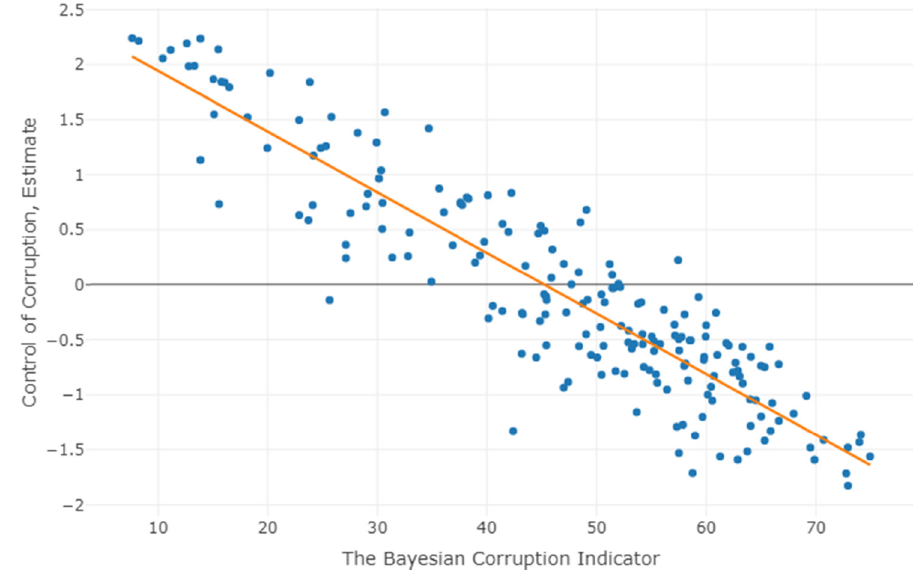
Figure 2: Control of corruption vs the Bayesian Corruption Index. Source: The Quality of Government Institute. Year 2017.